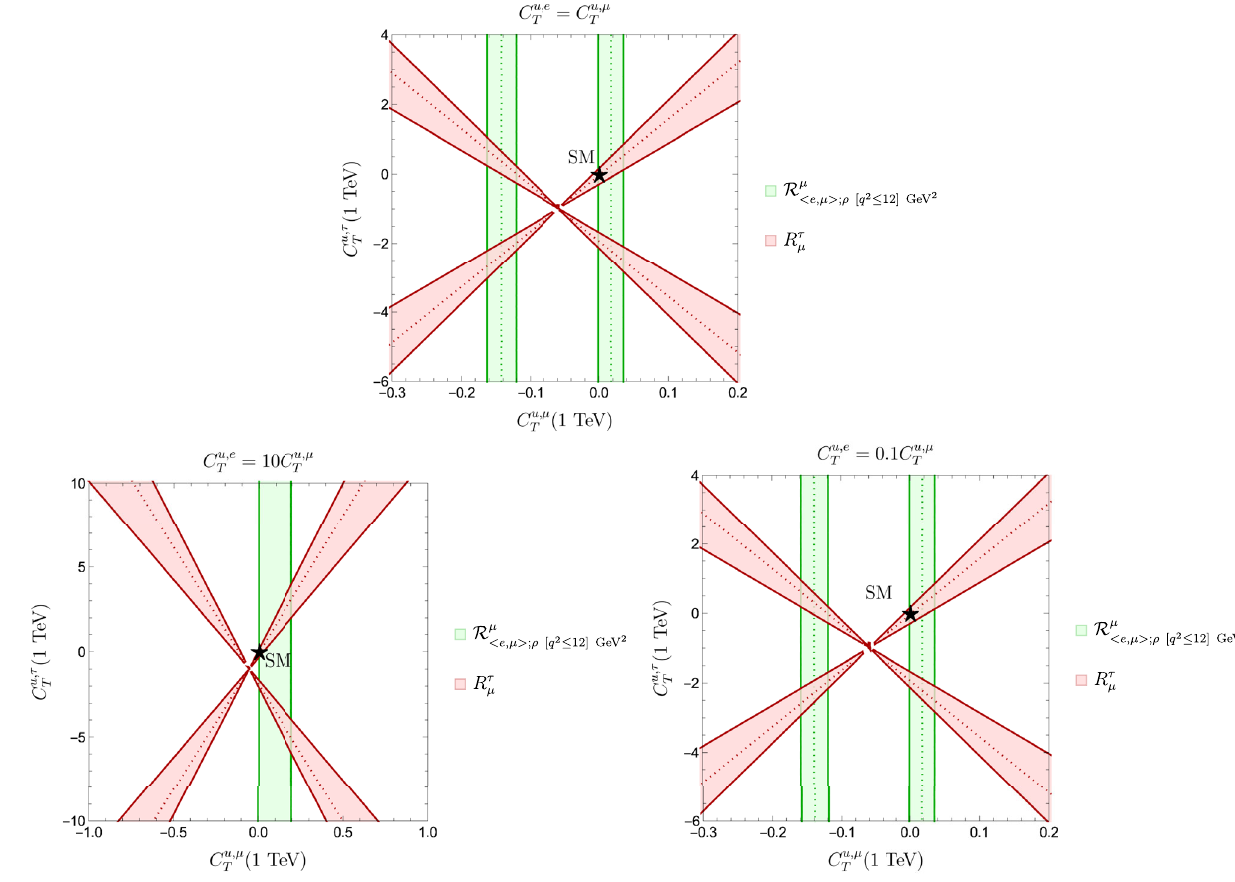
,μ Fig. 7 Constraints in the C u – C u ,τ plane for the observables listed in the text. The three plots correspond to different assumptions about the T T ,μ and C u , as indicated relation between C u , e T T Table 1 Bounds on the short-distance coefficients from the constraints ,μ on C u and C u ,τ , along with the allowed range for | V ub | from (cid:7) (cid:8) P P B ( ¯ B → ρ(cid:2) (cid:6)− ¯ ν (cid:2) (cid:6) ) [ (cid:2) (cid:6) = e ,μ ] , q 2 ≤ 12 GeV 2 , in the scenario where C = C u ,μ Scenario: C u , e P